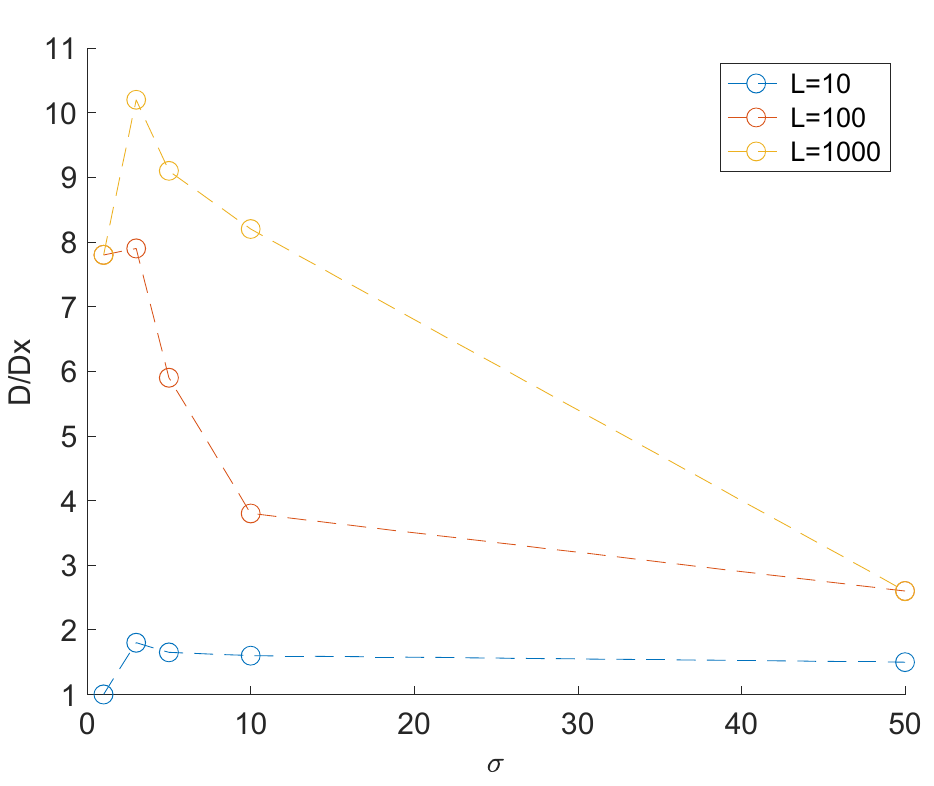
Figure 6. The ratio of the measured and calculated delay for the Rayleigh distribution with parameters µ = 0, σ = 300 B depending on the magnitude of a single outlier in σ for several fixed sets of sample